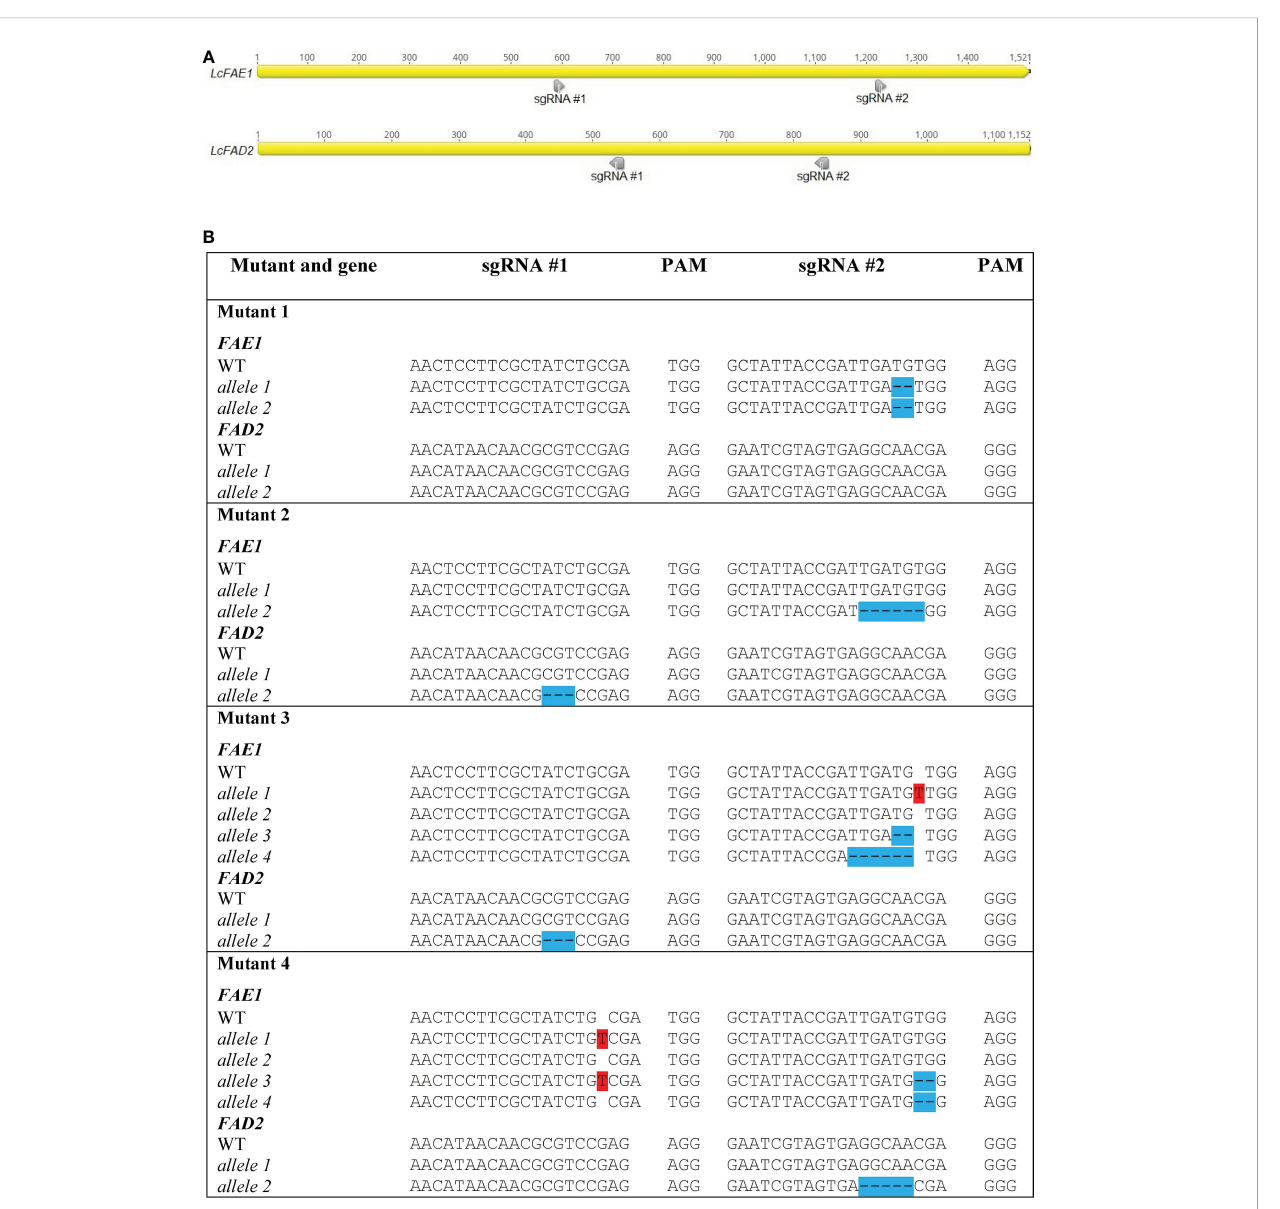
FIGURE 1 Locations of sgRNAs selected (A) and types of mutations detected in FAE1 and FAD2 in different mutant lines (B) . Insertions are highlighted in red. Deletions are highlighted in blue. (See also chromatographs from Sanger sequencing in Supplementary Figure